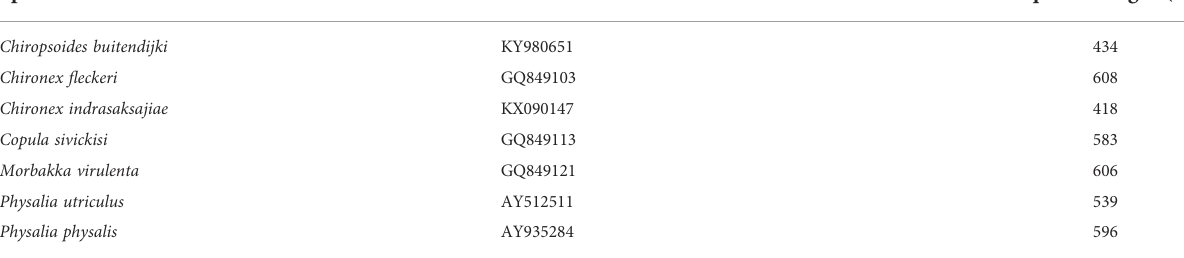
TABLE 2 Details of the 16S rRNA sequences used in this